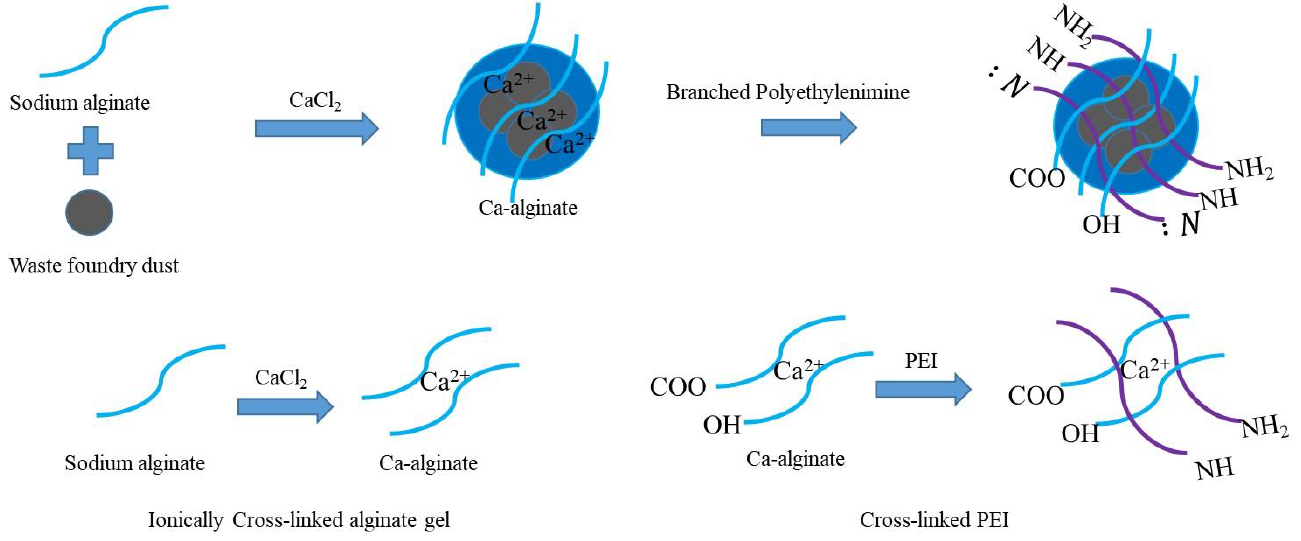
Figure 1. Schematic diagram for the preparation of WFD/SA-PEI.